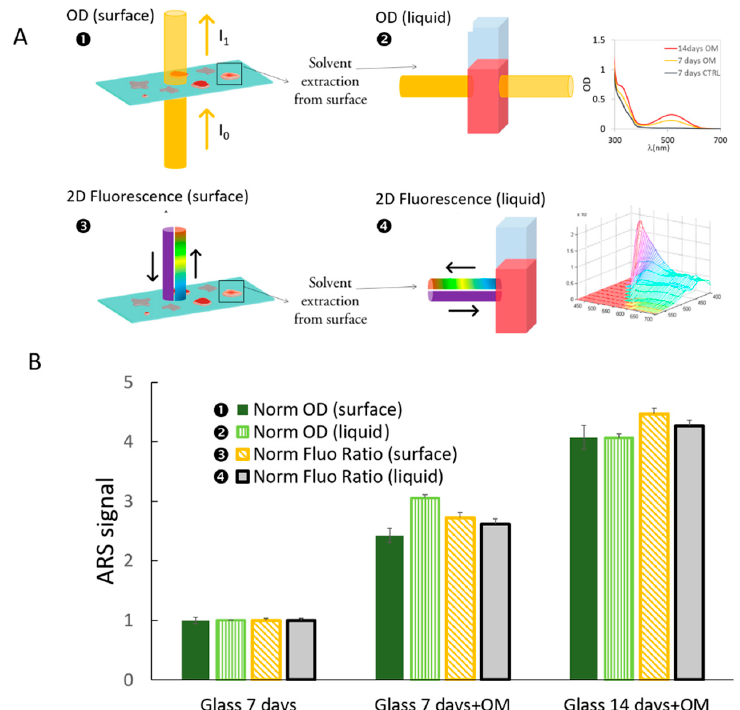
Figure 3. ( A ) Illustration of the four methods used for quantification of ARS staining. The OD and Normalized fluorescence ratios were both quantified after solvent extraction (“liquid”) or directly in situ (“surface”). ( B ) Histogram of methods used to quantify mineralization via ARS staining. Three samples are compared: glass after seven days without induction, and glass after 7 and 14 days with OM induction.